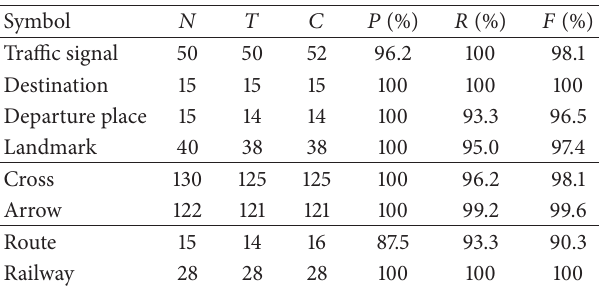
Figure 14: Experience in PPT: the vertical axis indicates the number of participants. Table 1: Experimental results are as follows: 𝑁 is the number of all objects for the symbol, 𝑇 is the number of objects correctly classified as the symbol, 𝐶 is the number of objects classified as the symbol, 𝑃 is precision, 𝑅 is recall, and 𝐹 is 𝐹